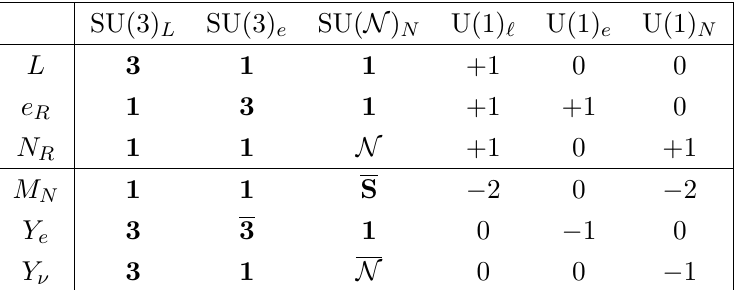
Table 1 . Global charges of (cid:12)elds and spurions in the lepton